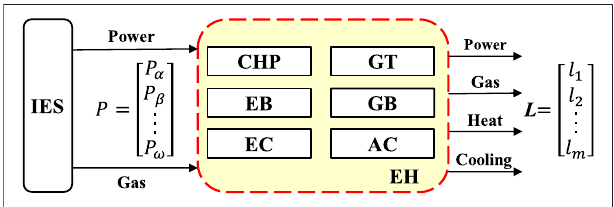
FIGURE 1 | IES structure based on